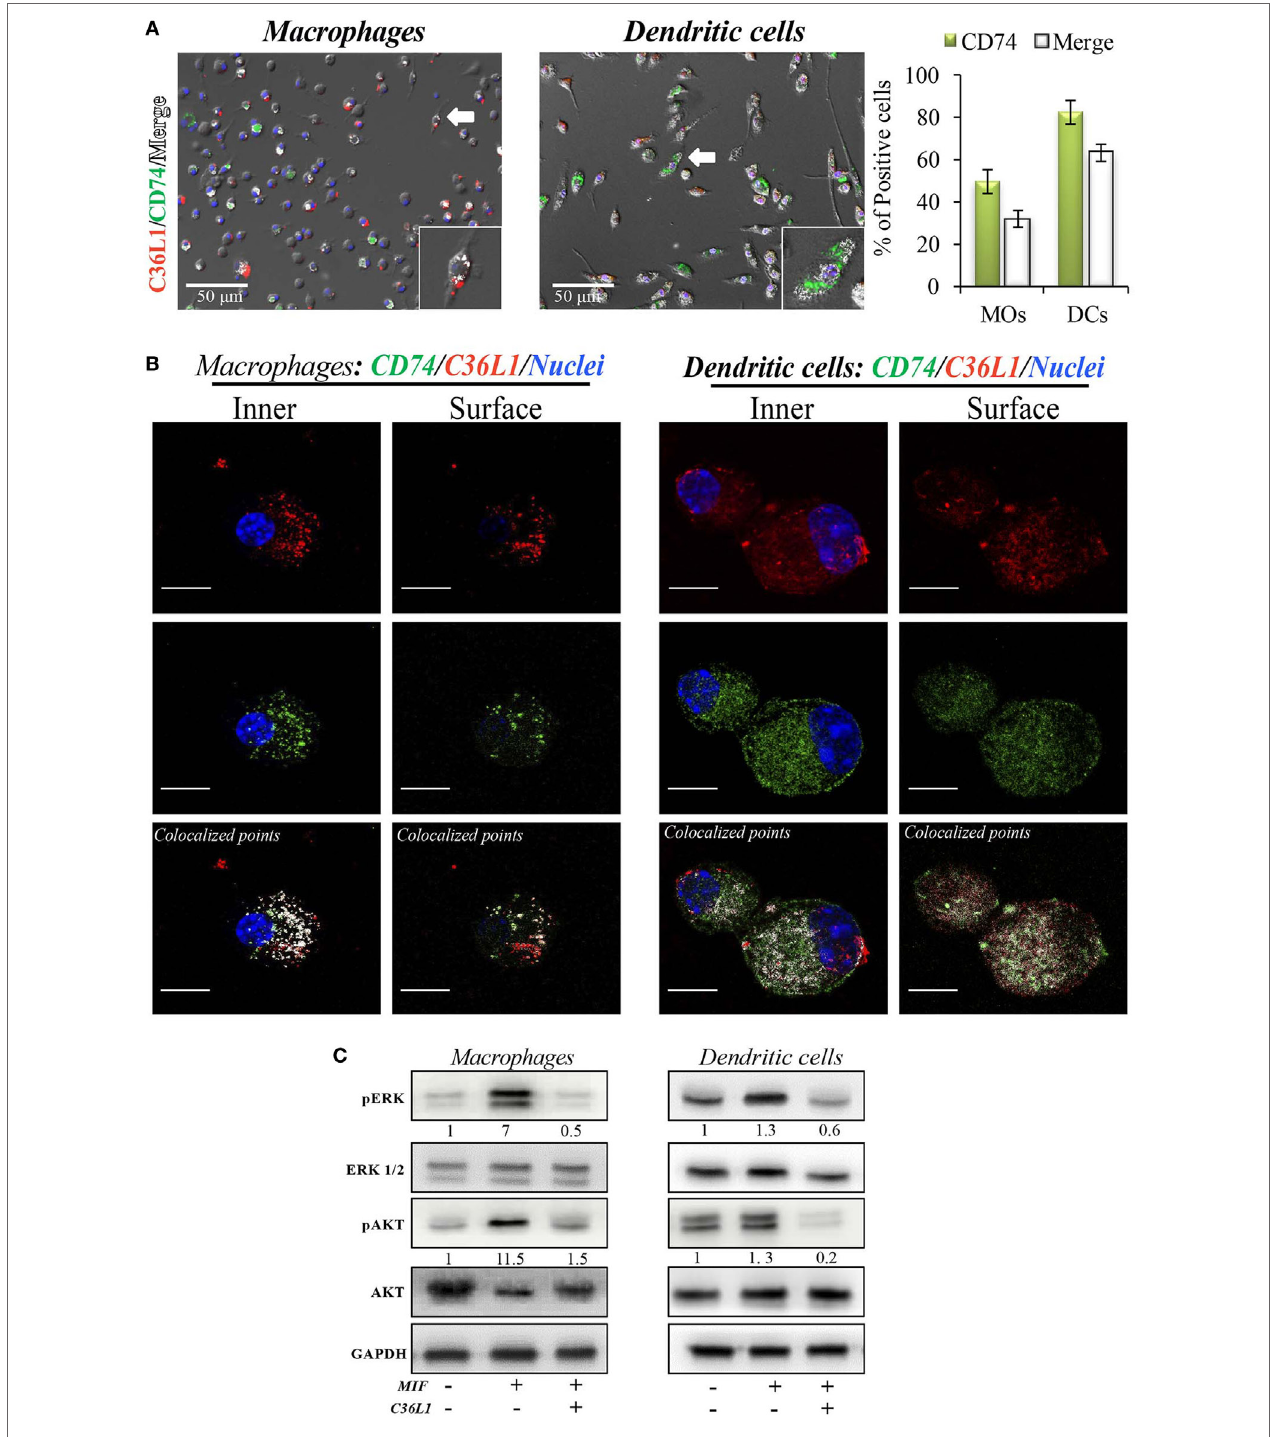
FigUre 5 | C36L1 interacts with CD74 in both macrophages (MOs) and dendritic cells (DCs) and inhibits macrophage migration inhibitory factor (MIF)/CD74 signaling. (a) Immunofluorescent staining of C36L1 (red), CD74 (green), and nuclei (blue) in primary MOs and DCs. CD74 interactions with C36L1 were quantified using automated analysis in ImageJ. Arrows indicate merged channels depicted in white. Four fields per slide were quantified. Scale bars: 50 µm. (B) Representative fluorescent confocal microscopy images showing colocalization of C36L1 peptide (red) and CD74 (green) in the intracellular and surface focal plane of both primary MOs (left) and DCs (right). Co-localized points were detected using ImageJ colocalization algorithm, depicted in white. Scale bars: 10 µm. (c) Immunoblotting analysis of phosphorylated AKT and ERK1/2 on primary MOs (10 and 20 min, respectively) and DCs (5 min) previously treated with C36L1 (200 µg/mL) or left untreated, and further treated with recombinant MIF (200